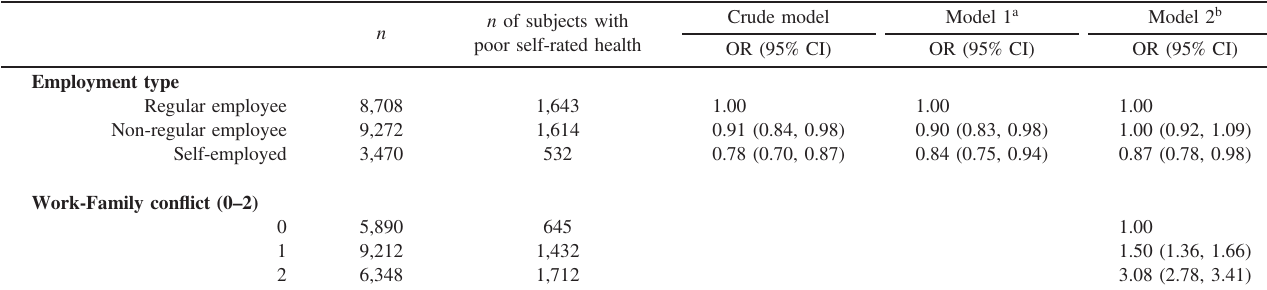
Table 2. Adjusted ORs of employment type for poor self-rated health among Japanese middle-aged women.